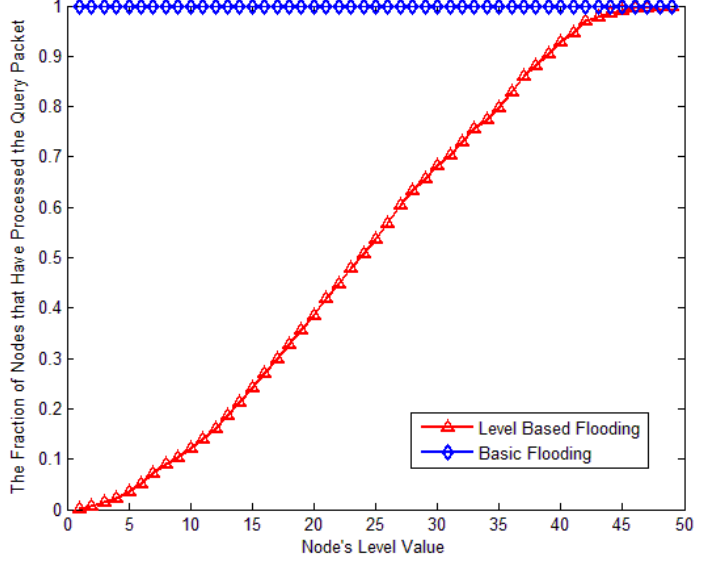
Figure 28. Fraction of nodes that have processed the query packet in Scenario